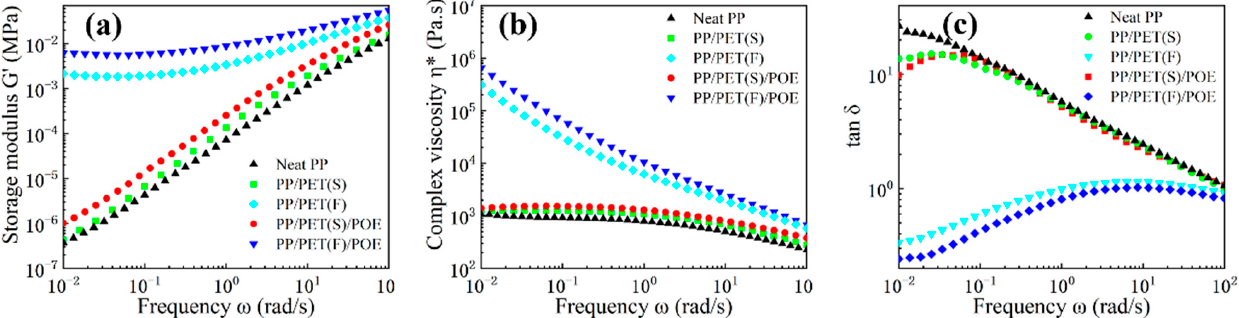
Figure 6. Rheological properties of neat PP, melt-blended and INF composites: ( a ) storage modulus (G ′ ), ( b ) complex viscosity ( η *) and ( c ) loss tangent (tan δ ).